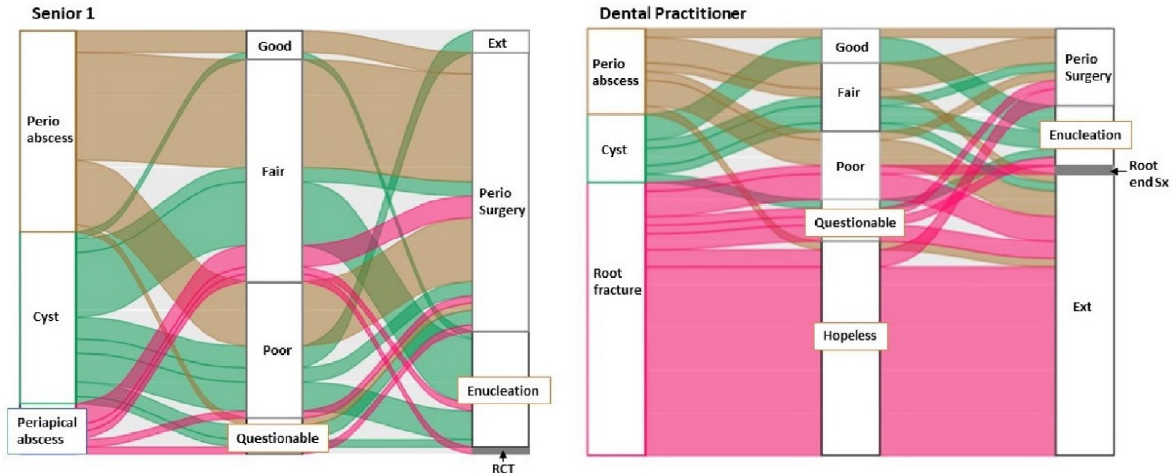
Figure 1. Distribution and correspondence of the diagnosis, prognosis, and treatment choice for Case A between the Senior 1 ( n = 59) and Dental practitioner ( n = 50) groups. Perio = periodontal, Ext = extraction, RCT = root canal therapy, Sx =